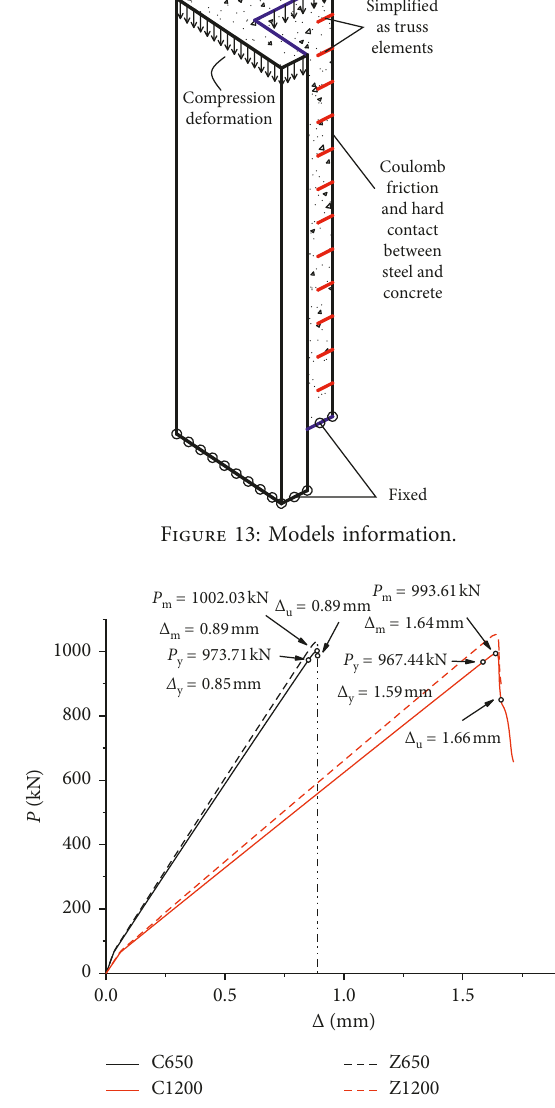
Figure 14: P - Δ curves of analysis results and comparison with experimental results.